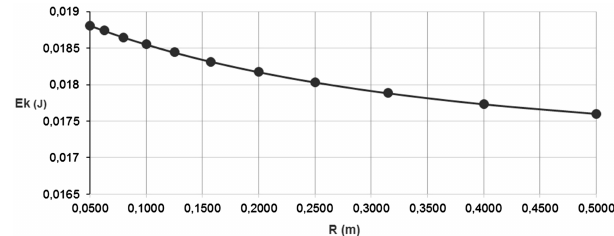
Figure 6. Dependence of kinetic energy E k and radius R of the drive pulley at velocity v 0 = 2ms − 1 .